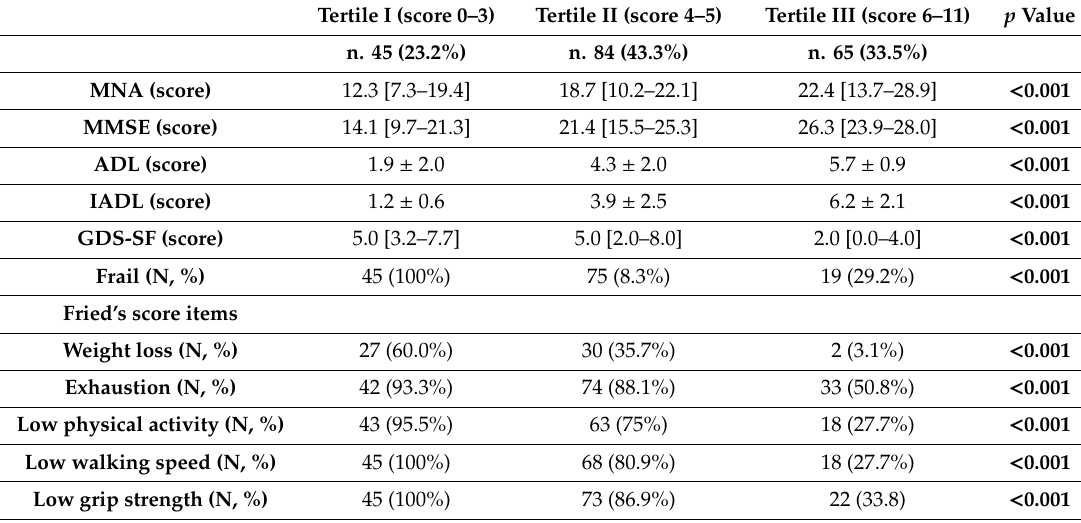
Table 2. Nutritional status, cognitive status, physical performance, depression and frailty status in patients at baseline, according to study groups.